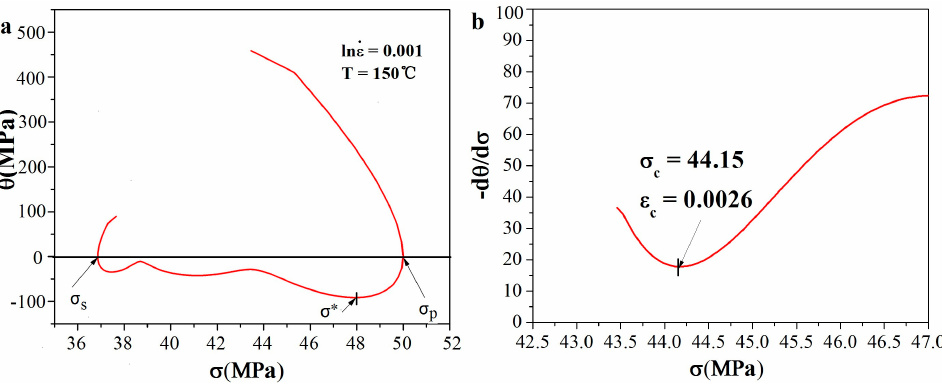
Figure 5. Relationship between θ and σ : ( a ) θ – σ ; ( b ) − ( ∂θ / ∂σ ) − σ .